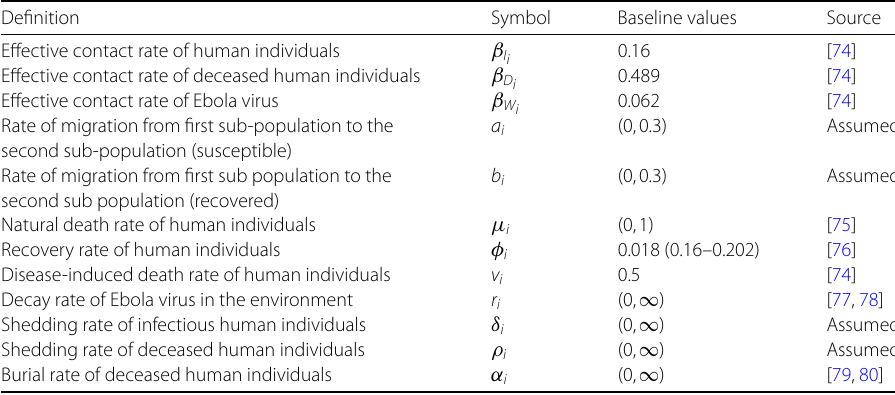
Table 1 Model parameters, i = 1,2, for patch 1 and 2 respectively. The time unit is in